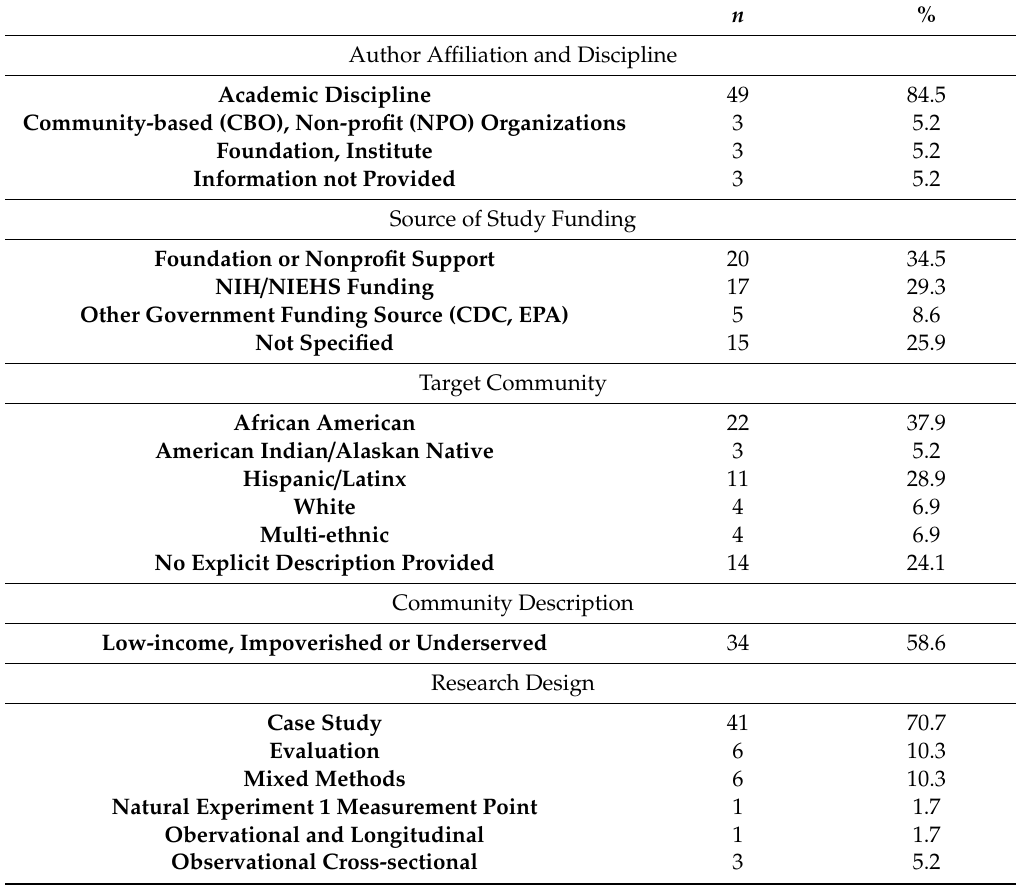
Table 3. Review Article Characteristics, n =